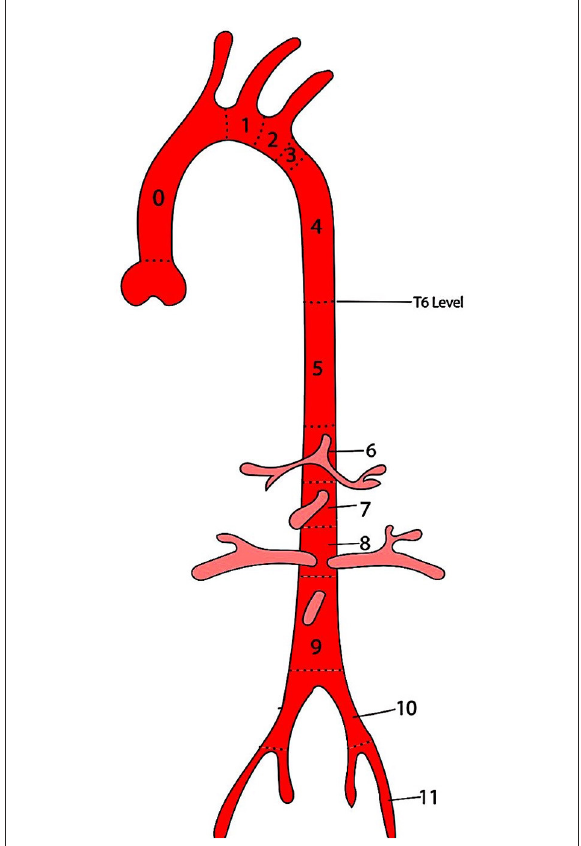
FIGURE1 Ishimaru anatomical landing zone map. The positions of the proximal and distal ends of the stent-graft are described by zones (Z), which are based on lines drawn from the distal side of the branch arteries from the aorta.